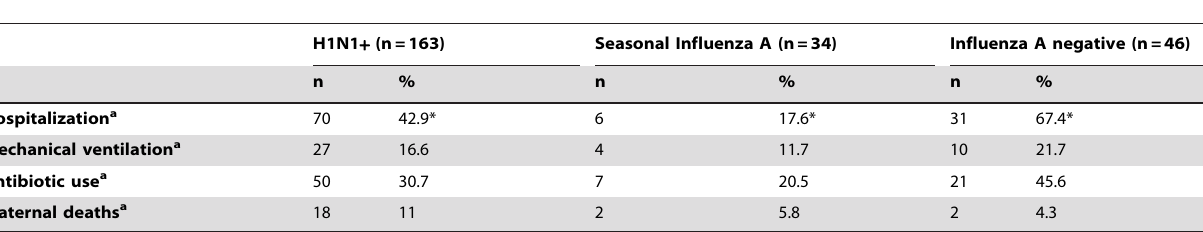
Table 1. Clinical parameters presented by pregnant women with influenza-like illness in south Brazil.